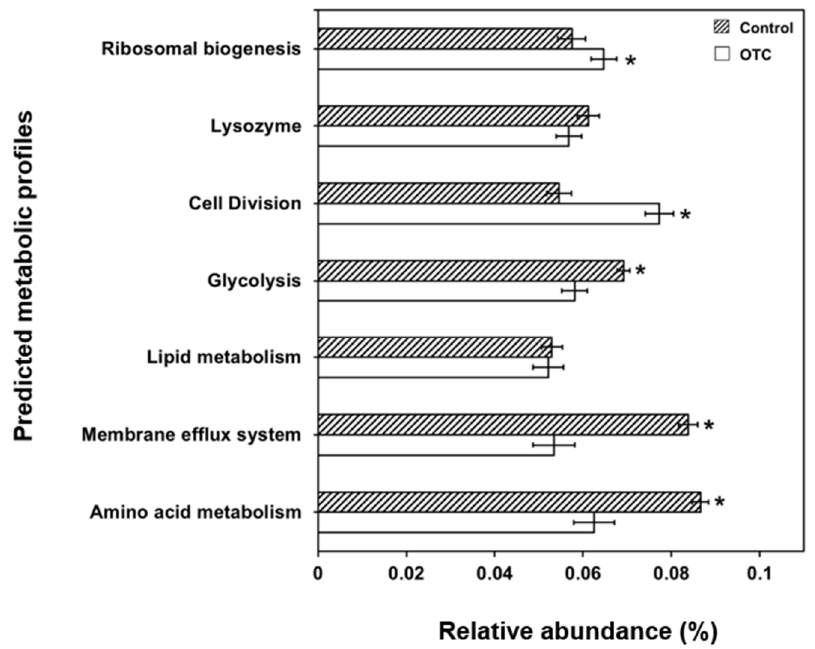
Figure 3. Relative abundance of PICRUSt-derived metabolic profiles of gut bacterial community of rainbow trout. Asterisk (*) denotes p < 0.05 by Tukey’s test.